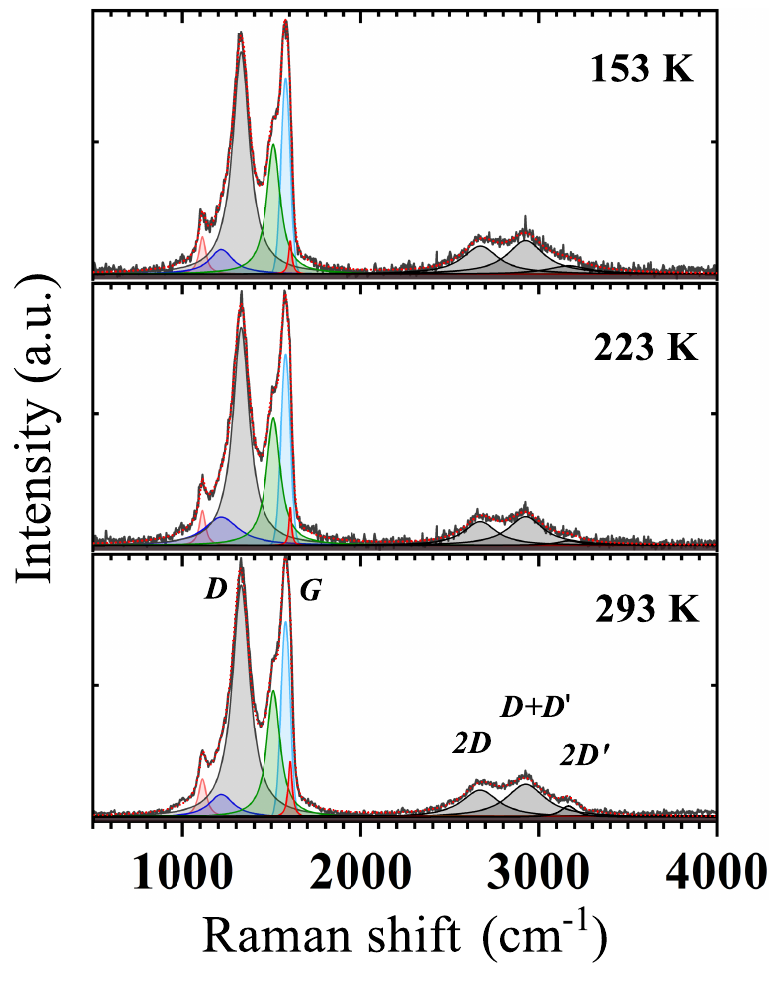
Figure 6. Raman spectra of the GS at different temperatures. Letters are used to label by convention the main peaks in the spectra. The Lorenzian and Voigt ( G -peak only) peak contributions are shown as coloured shaded